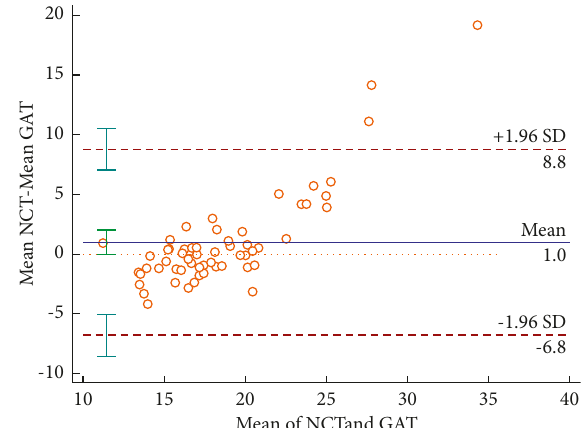
Figure 1: Bland–Altman’s analysis of the mean IOP between NCT and